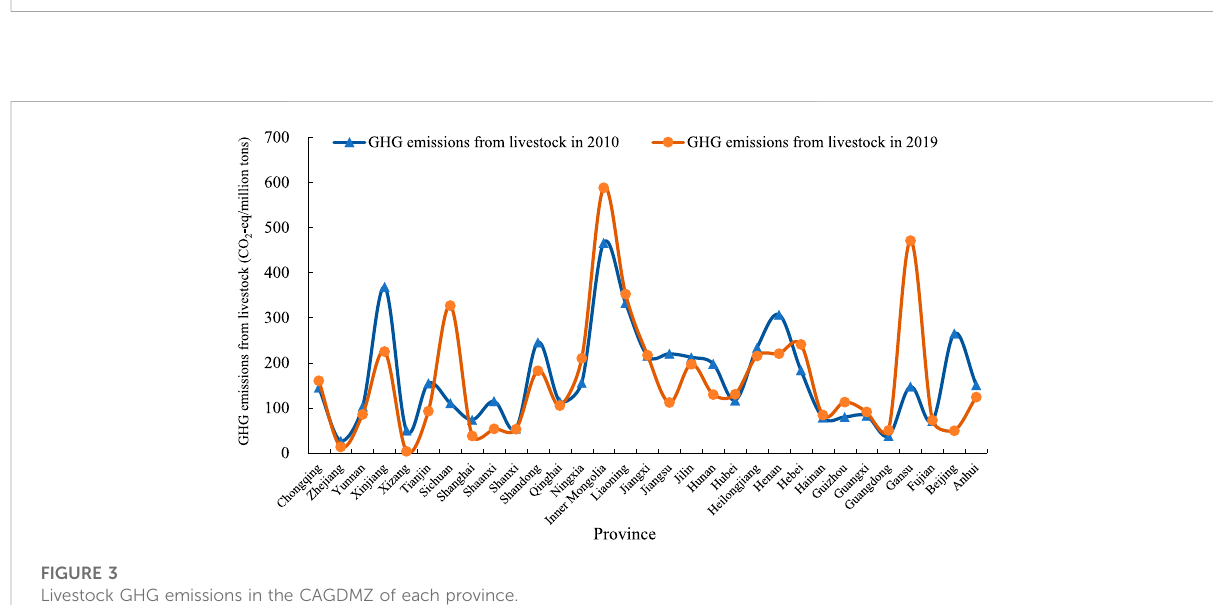
FIGURE 3 Livestock GHG emissions in the CAGDMZ of each